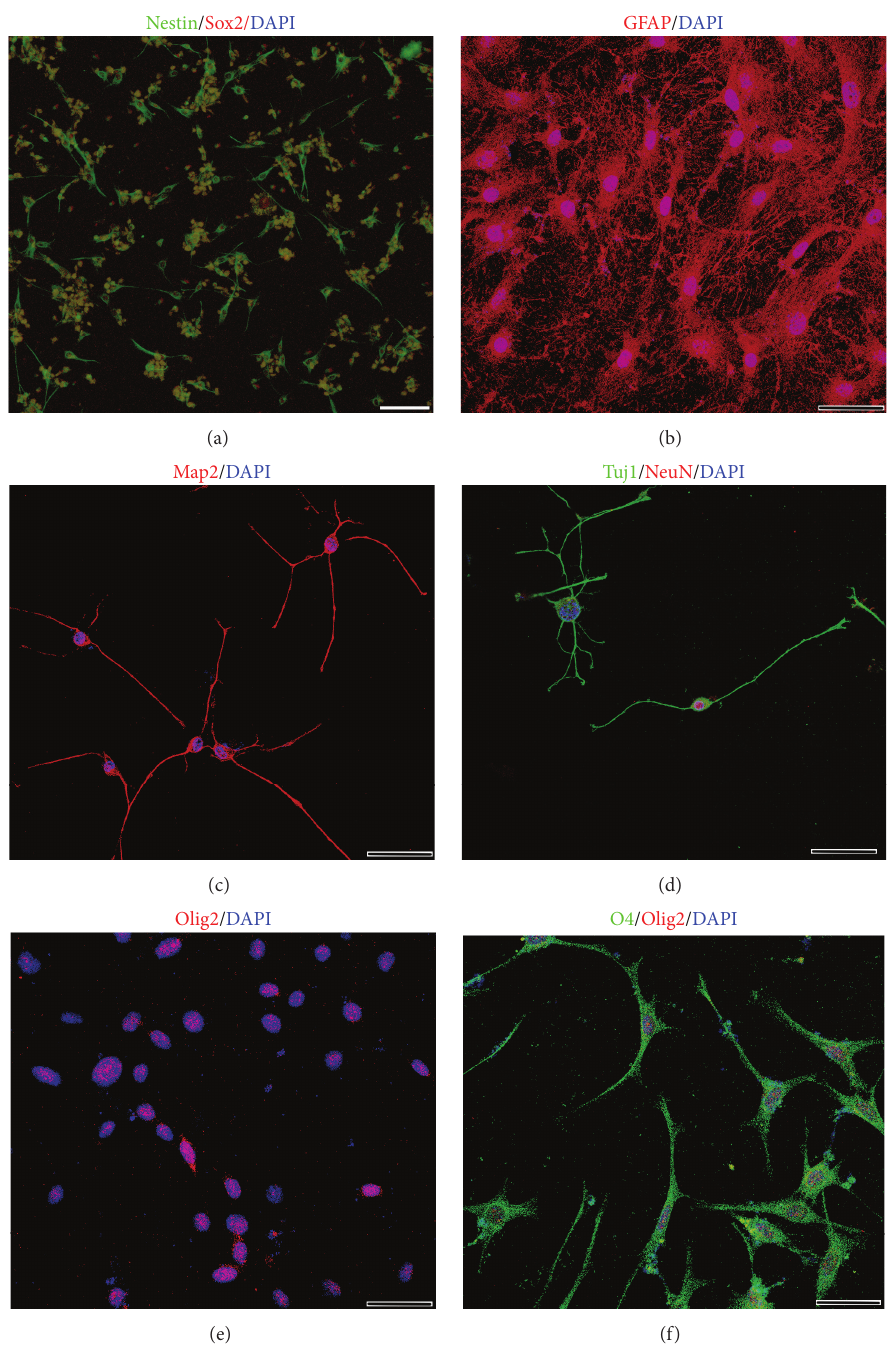
Figure 5: Feeder-free SMINS-TTF-3 cells (FF SMINS3). TTF were seeded on PDL coated dishes in stem cell medium containing Bix01294, RG108, and PD0325901 for two weeks and then transferred into NSC medium in petri dishes for two weeks. (a) The FF SMINS3 cells were stained by neural stem cell markers Sox2 and Nestin. (b–f) The FF SMINS3 cells differentiated to astrocytes (GFAP), neurons (Tuj1, Map2, and NeuN), and oligodendrocytes (Olig2 and O4) in specific differentiation medium. DAPI was used for nuclei counterstaining (blue). Scale bar: 100 𝜇 m (a) and 50 𝜇 m